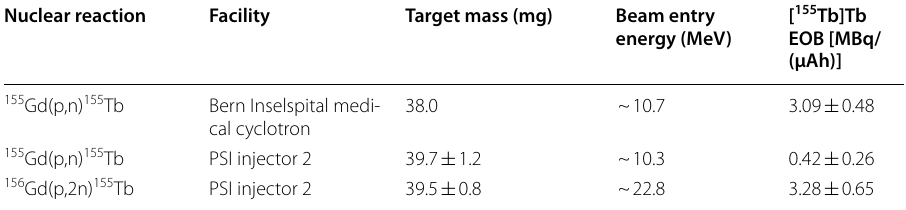
Table 1 Terbium-155 activities produced via 155 Gd(p,n) 155 Tb and 156 Gd(p,2n) 155 Tb nuclear reactions at PSI’s IP 2 irradiation station and Bern medical